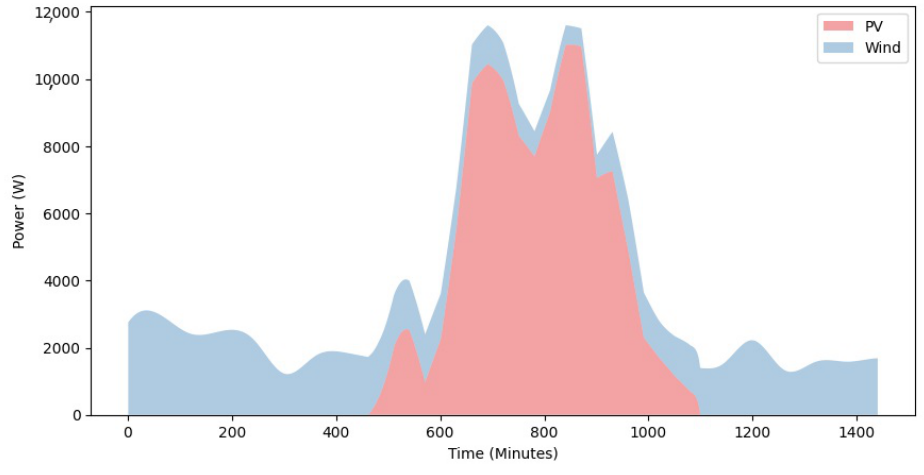
Figure 6. First day of the community production profile, considering PV and wind